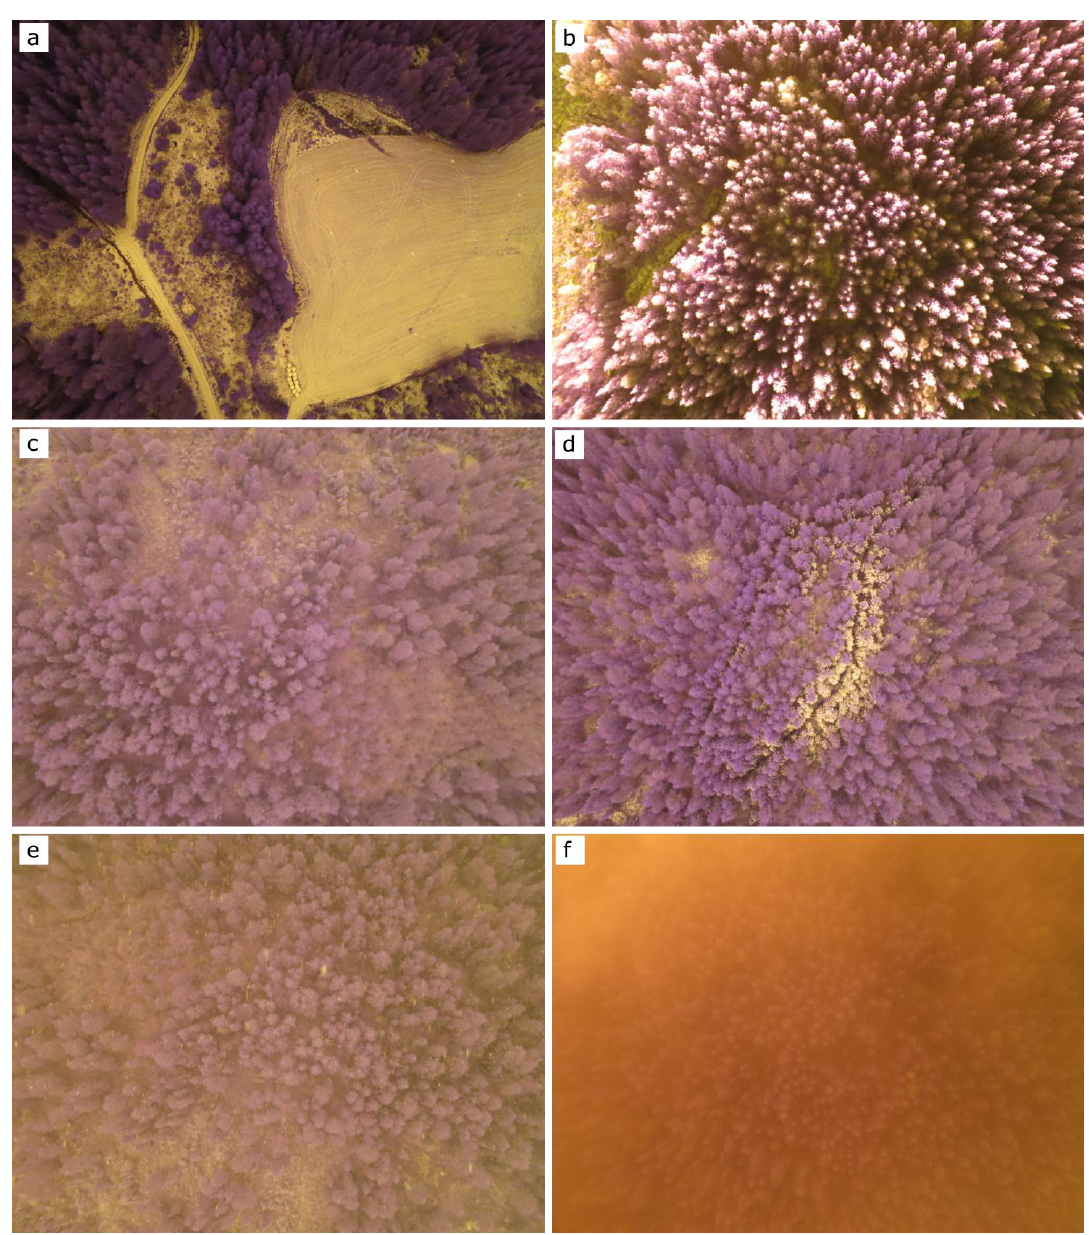
Figure 2. Factors affecting image quality. In general, is possible to see that the imagery was characterized by large perspective distortions and different light and atmospheric conditions in different flights. In particular: ( a ) saturation due to the high scene contrast causing the forest to look dark; ( b ) during the sunny flight, the tree tops were saturated due to illumination of only the tree tops enhanced by the low sun angle; ( c ) blurriness caused by high wind speed (7 m∙sec −1 ); ( d ) presence of snow on some parts of the canopy causing these parts to have an anomalous spectral response with regard to the object represented; ( e ) presence of snowflakes in the images due to precipitation during image acquisition; ( f ) presence of fog during image acquisition, which reduced the visibility and sharpness of the